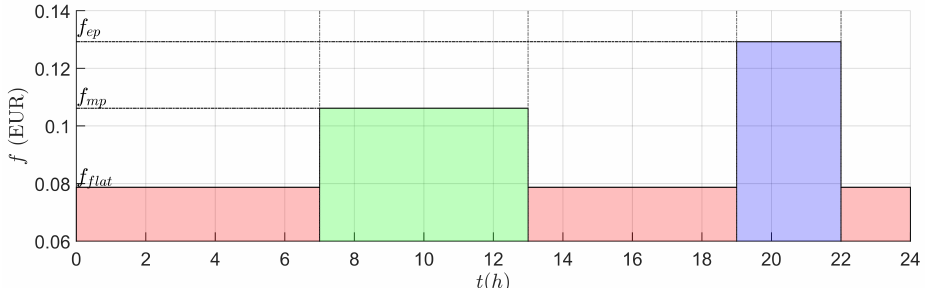
Figure 1. Energy price chart according to chosen energy